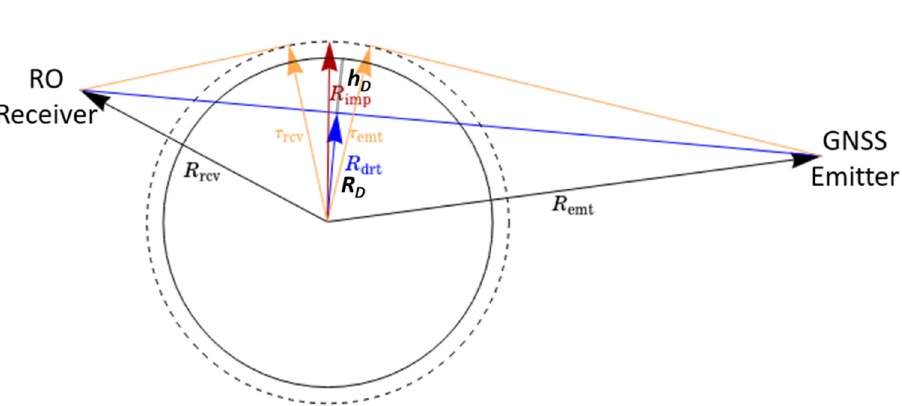
Figure 1. Illustration of RO limb sounding configuration and geometric parameters used to predict RO limb sounding opportunities.